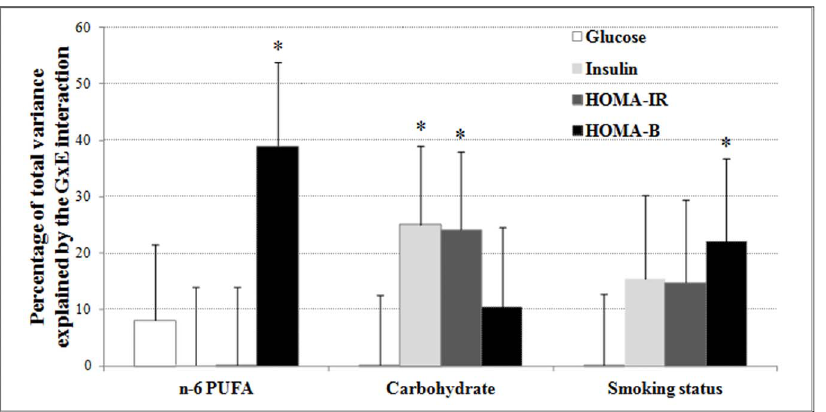
Figure 2. Estimated amount of variance by GxE interaction of three E factors for four diabetes traits. The GxE variance is shown as the percentage of the total phenotypic variance of each trait. * P , 0.05 indicates nominal significant contribution to total variance.